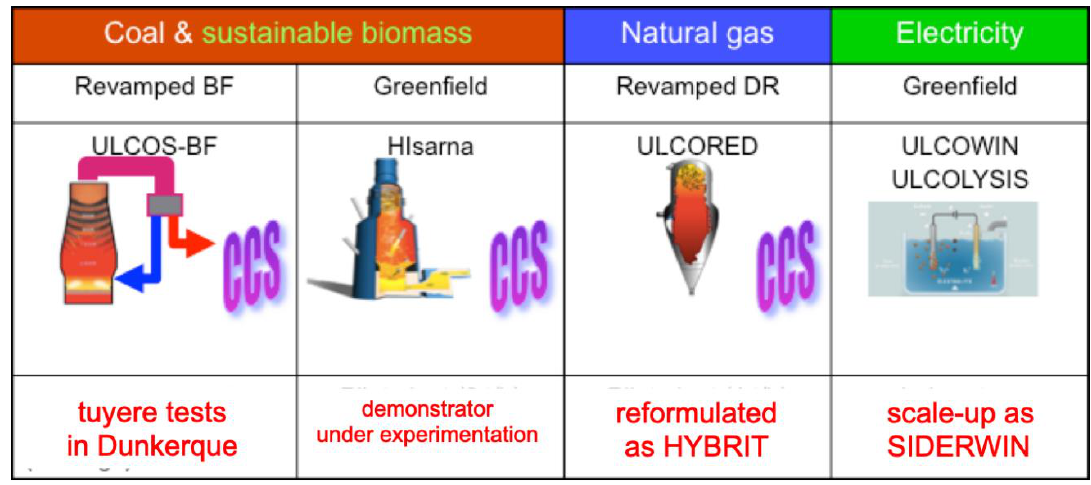
Figure 21. The ULCOS solutions and their present status.